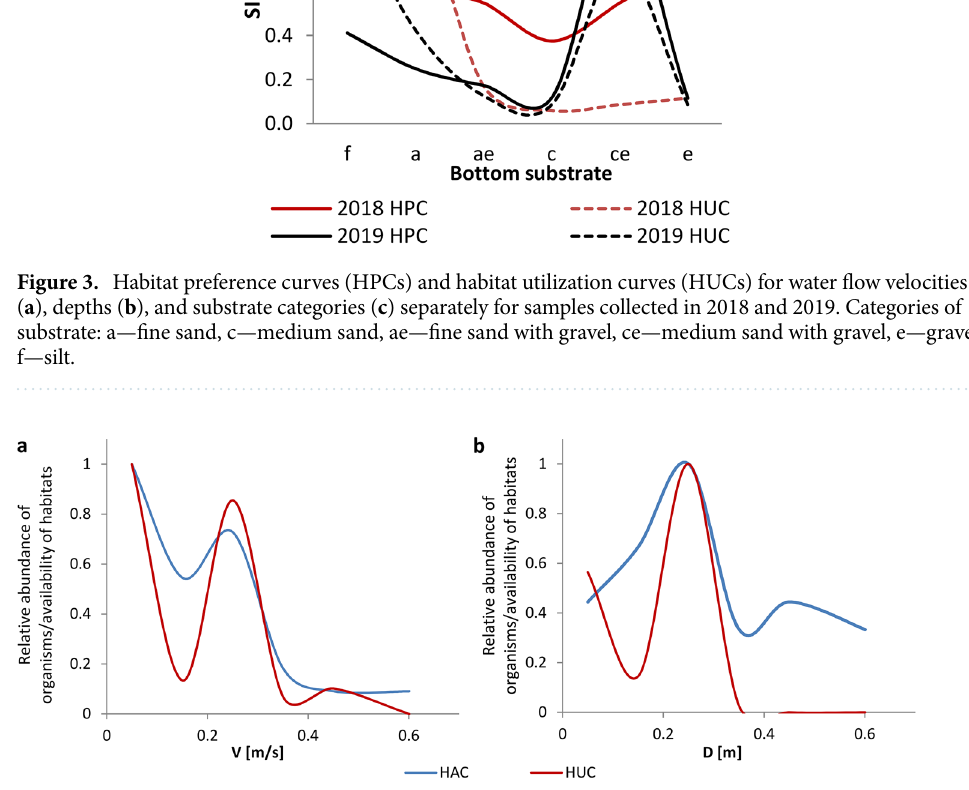
Figure 4. Habitat availability curves (HACs) and habitat utilization curves (HUCs) for the 2019 samples for water flow velocities ( a ) and depths ( b